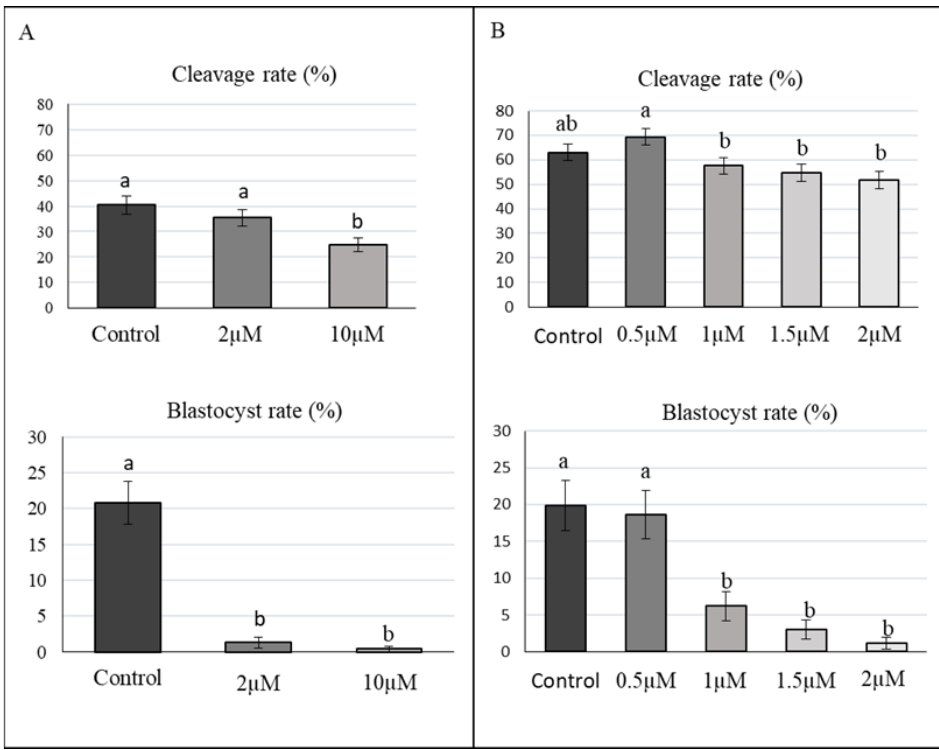
Figure 4. Effect of aphidicolin in porcine embryo development. ( A ) Cleavage and blastocyst rates for in vitro derived porcine embryos cultured with 0 (control), 2 and 10 µM aphidicolin. ( B ) Cleavage and blastocyst rate of in vitro derived porcine embryos cultured with 0 (control), 0.5, 1, 1.5, and 2 µM aphidicolin. Cleavage rate (%): Two-cell embryos per total number of inseminated oocytes. a,b Values with different superscripts are significantly different ( p < 0.05).